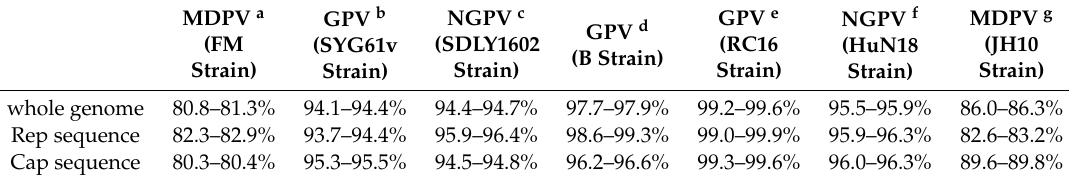
Table 2. Gene homology comparisons with other avian